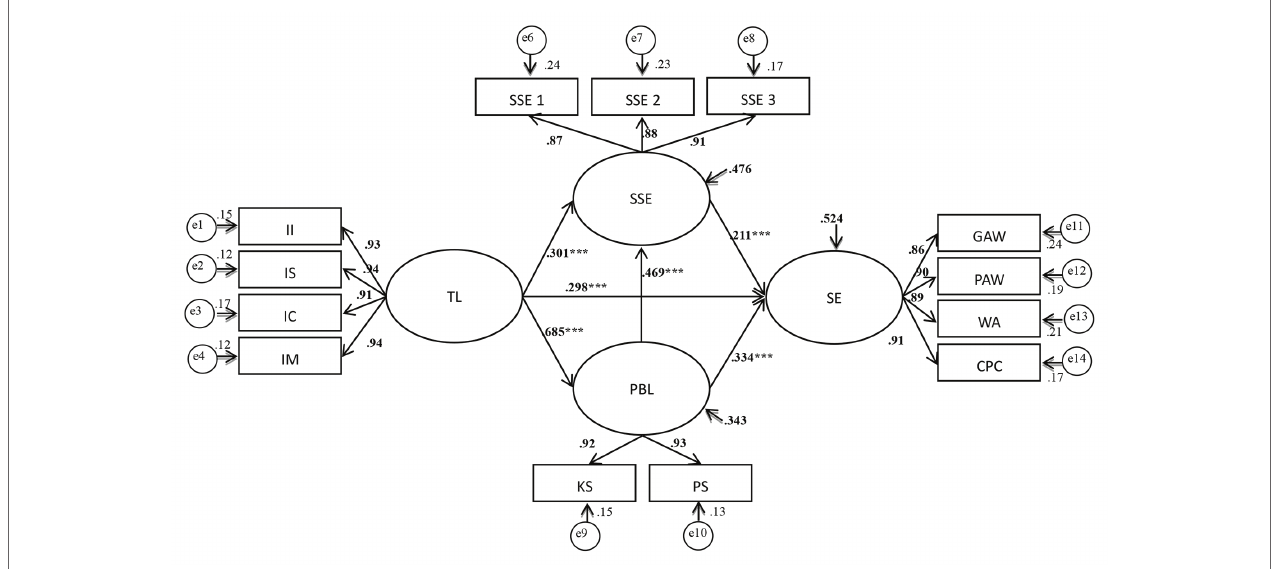
FIGURE 2 | Structural model.